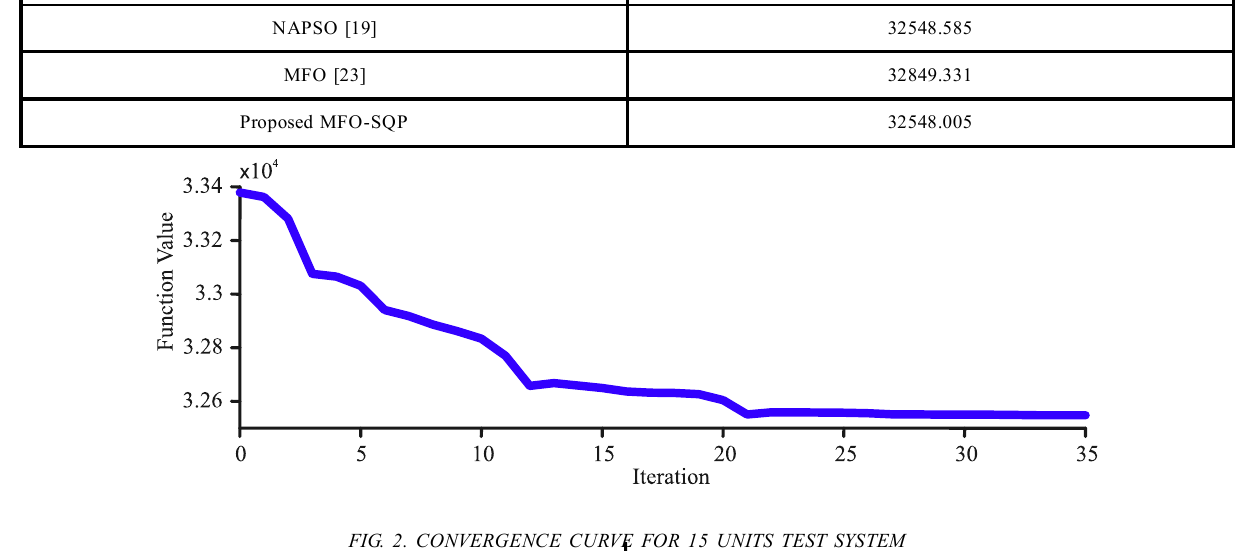
FIG. 2. CONVERGENCE CURVE FOR 15 UNITS TEST